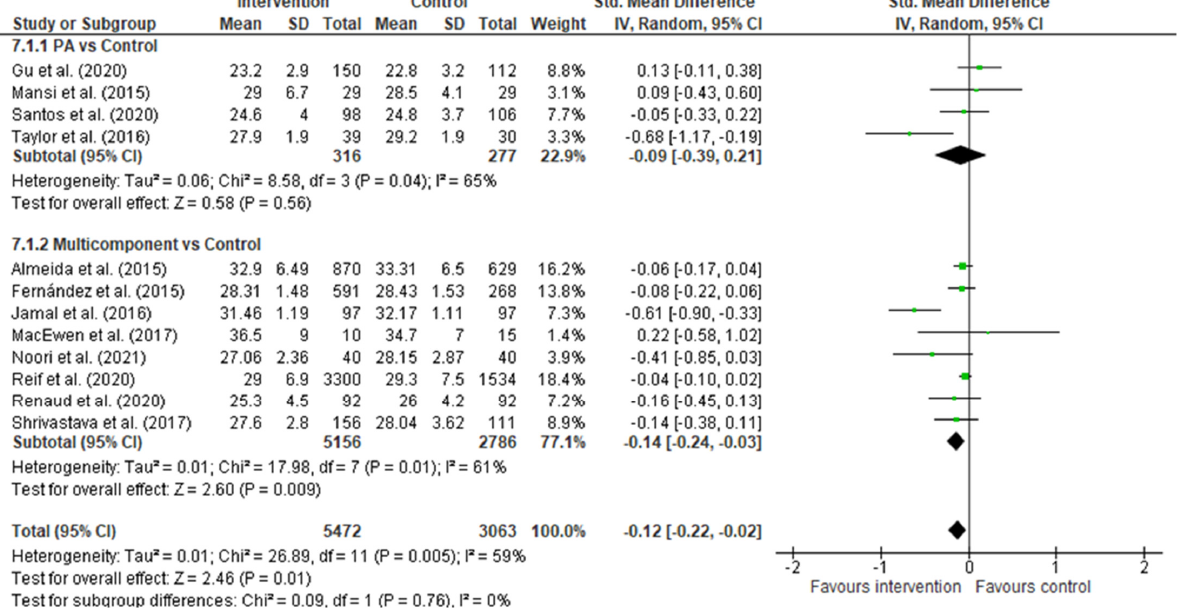
Figure 5. Funnel Plot.